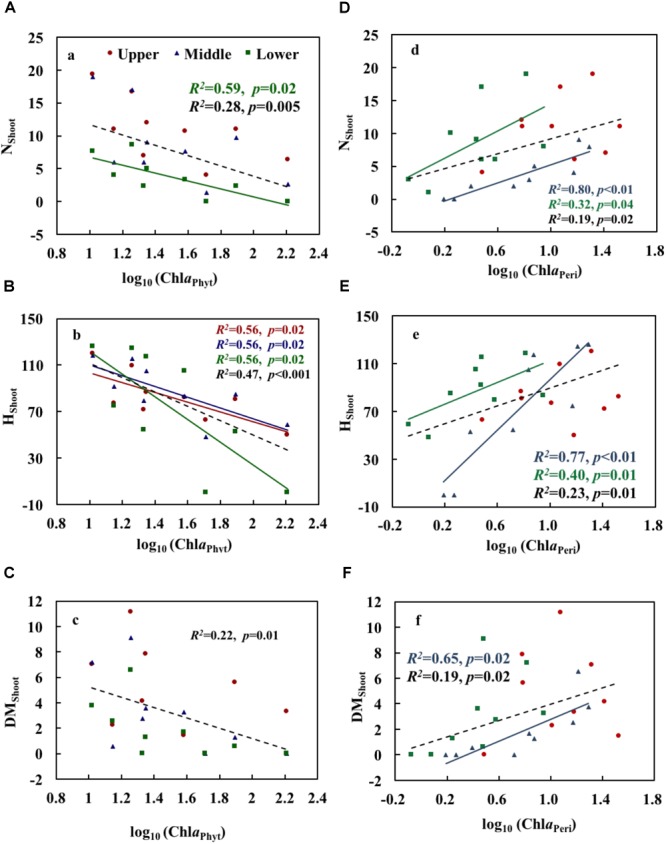
Relationships of phytoplankton chlorophyll a
(A–C) and periphyton chlorophyll a
(D–F) with the growth and physiological variables of Potamogeton crispus. Upper, middle, and lower represent the layer at 0.4, 0.8, and 1.2 m below the water surface. The dotted line shows significant relationships of pooled data from all depths (n = 9). The red, blue, green, and black R2 and p correspond to the red, blue, green, and black line, respectively.